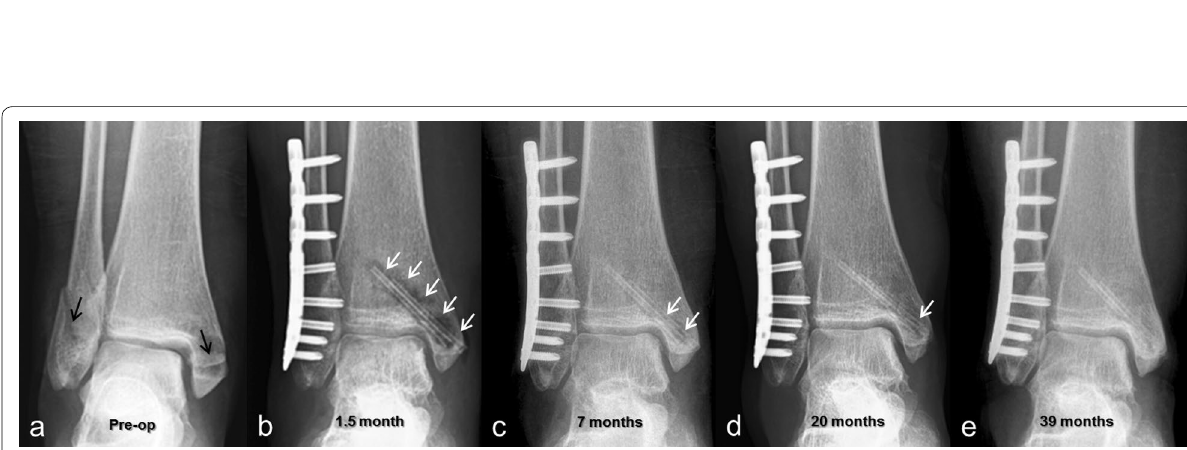
Fig. 2 a Preoperative AP ankle radiograph of 45-year-old female patient with a bimalleolar fracture at initial admission (black arrows showing fractures); b Lateral malleolar fracture fixed with plate and screws and medial malleolar fracture fixed with two bioabsorbable Mg screws. At 1.5-month follow-up, gas shadows were observed around screws (white arrows); c At 7th month visit, fracture was united, and significant decrease in gas shadows was seen; d At 20th month follow-up, almost no gas shadows were visible; e At final follow-up, faded silhouette of screws